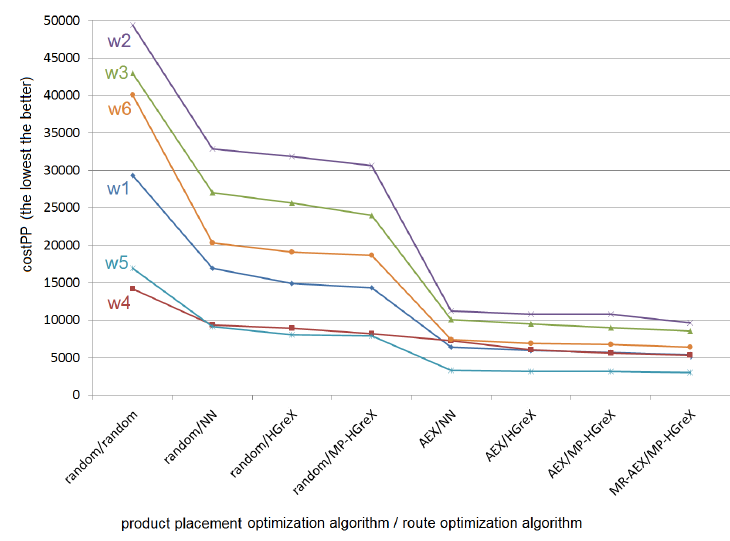
Figure 9. Graphical representation of the data from Table 4). On horizontal axis: the optimization methods with various improvements (see Section 5.4). On vertical axis: the product placement cost costPP (the lower the better) obtained with particular methods for the warehouses w1, w2, w3, w4, w5, w6 with corresponding lists of orders.